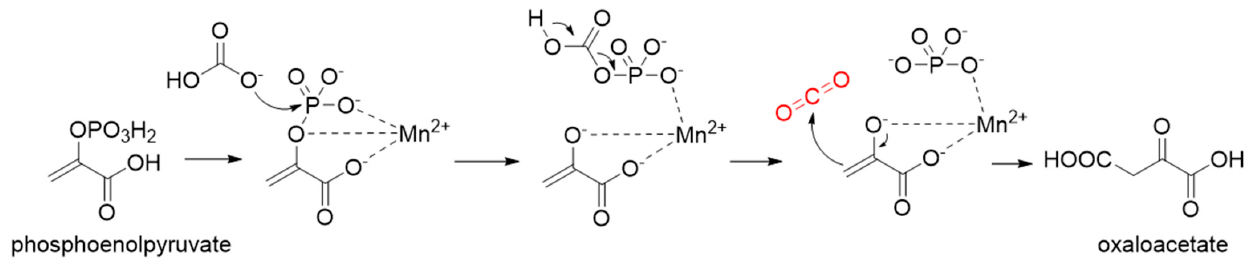
Figure 5. The catalytic mechanism of phosphoenolpyruvate carboxylase